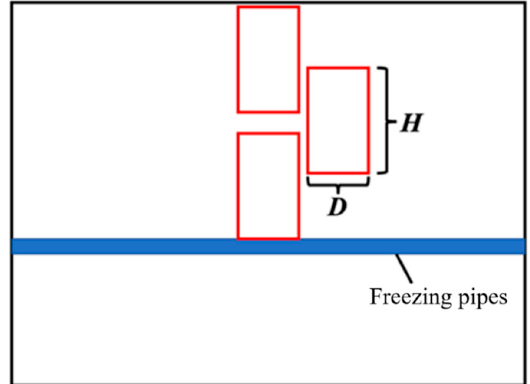
Figure 4. CT sampling diagram.